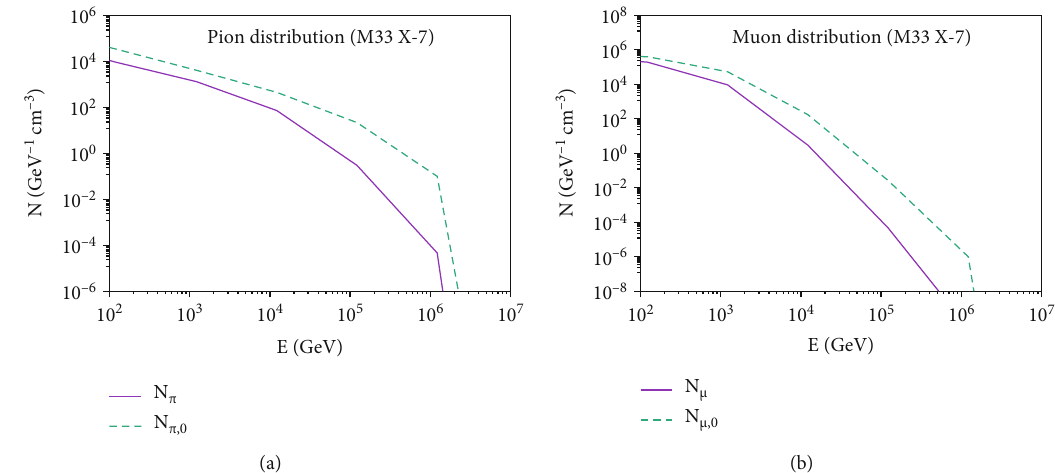
Figure 5: Pion (a) and muon (b) distributions for M33 X-7. In both cases of particles- j , we compare the distribution which considers the important energy losses N j ð E , z = z distributions refer to the base of the jet, i.e., at z = z